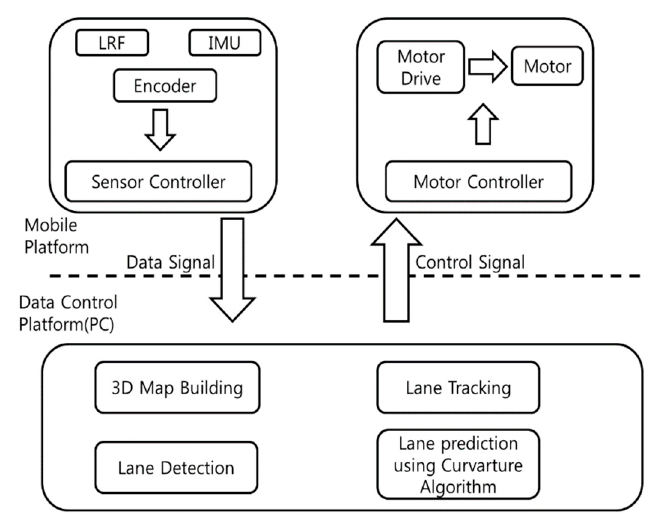
Figure 1. System configuration.